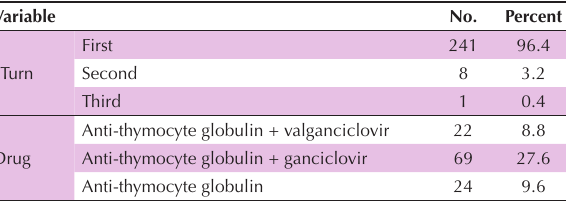
Table 2. Frequency of turn of transplantation and drugs received before transplant recipients